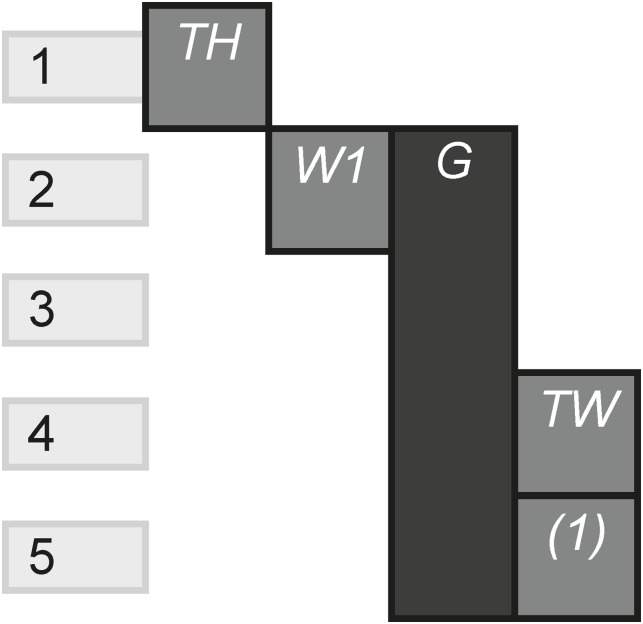
Audience centric.